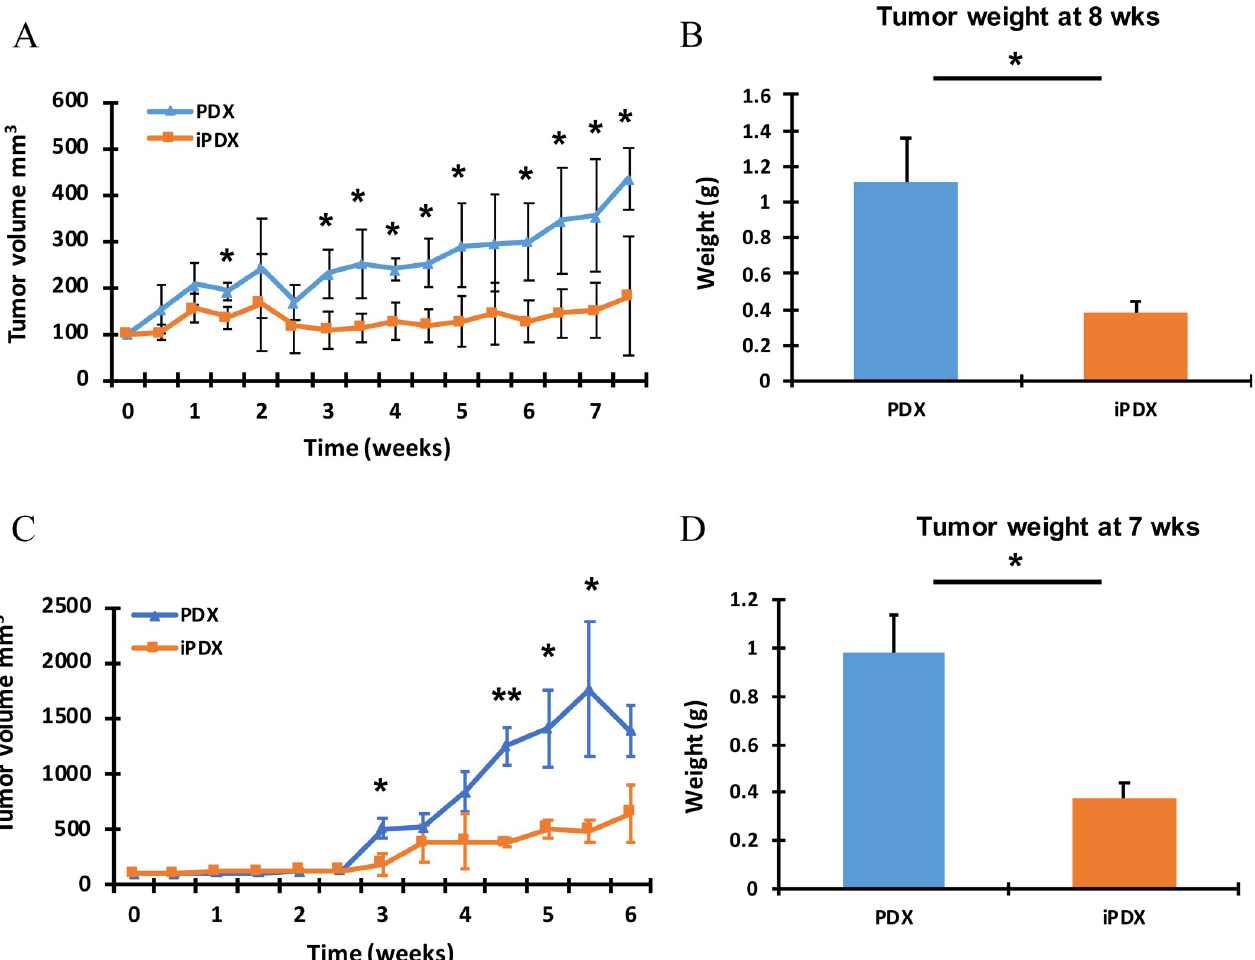
Fig 4. iPDX demonstrate reduced tumor growth compared with the corresponding PDX. Tumor (A) Average tumor volume (mm3) measured over time in the MCC model. (B) Final tumor weight (g) average in the MCC model. Data from samples collected at 8 weeks. (C) Average tumor volume (mm3) measured over time in the MPC model. (D) Final tumor weight (g) average in the MPC model. Data from samples collected at 7 weeks. Values represent mean of three animals per group ± SD. � p < 0.05. �� p < 0.005.